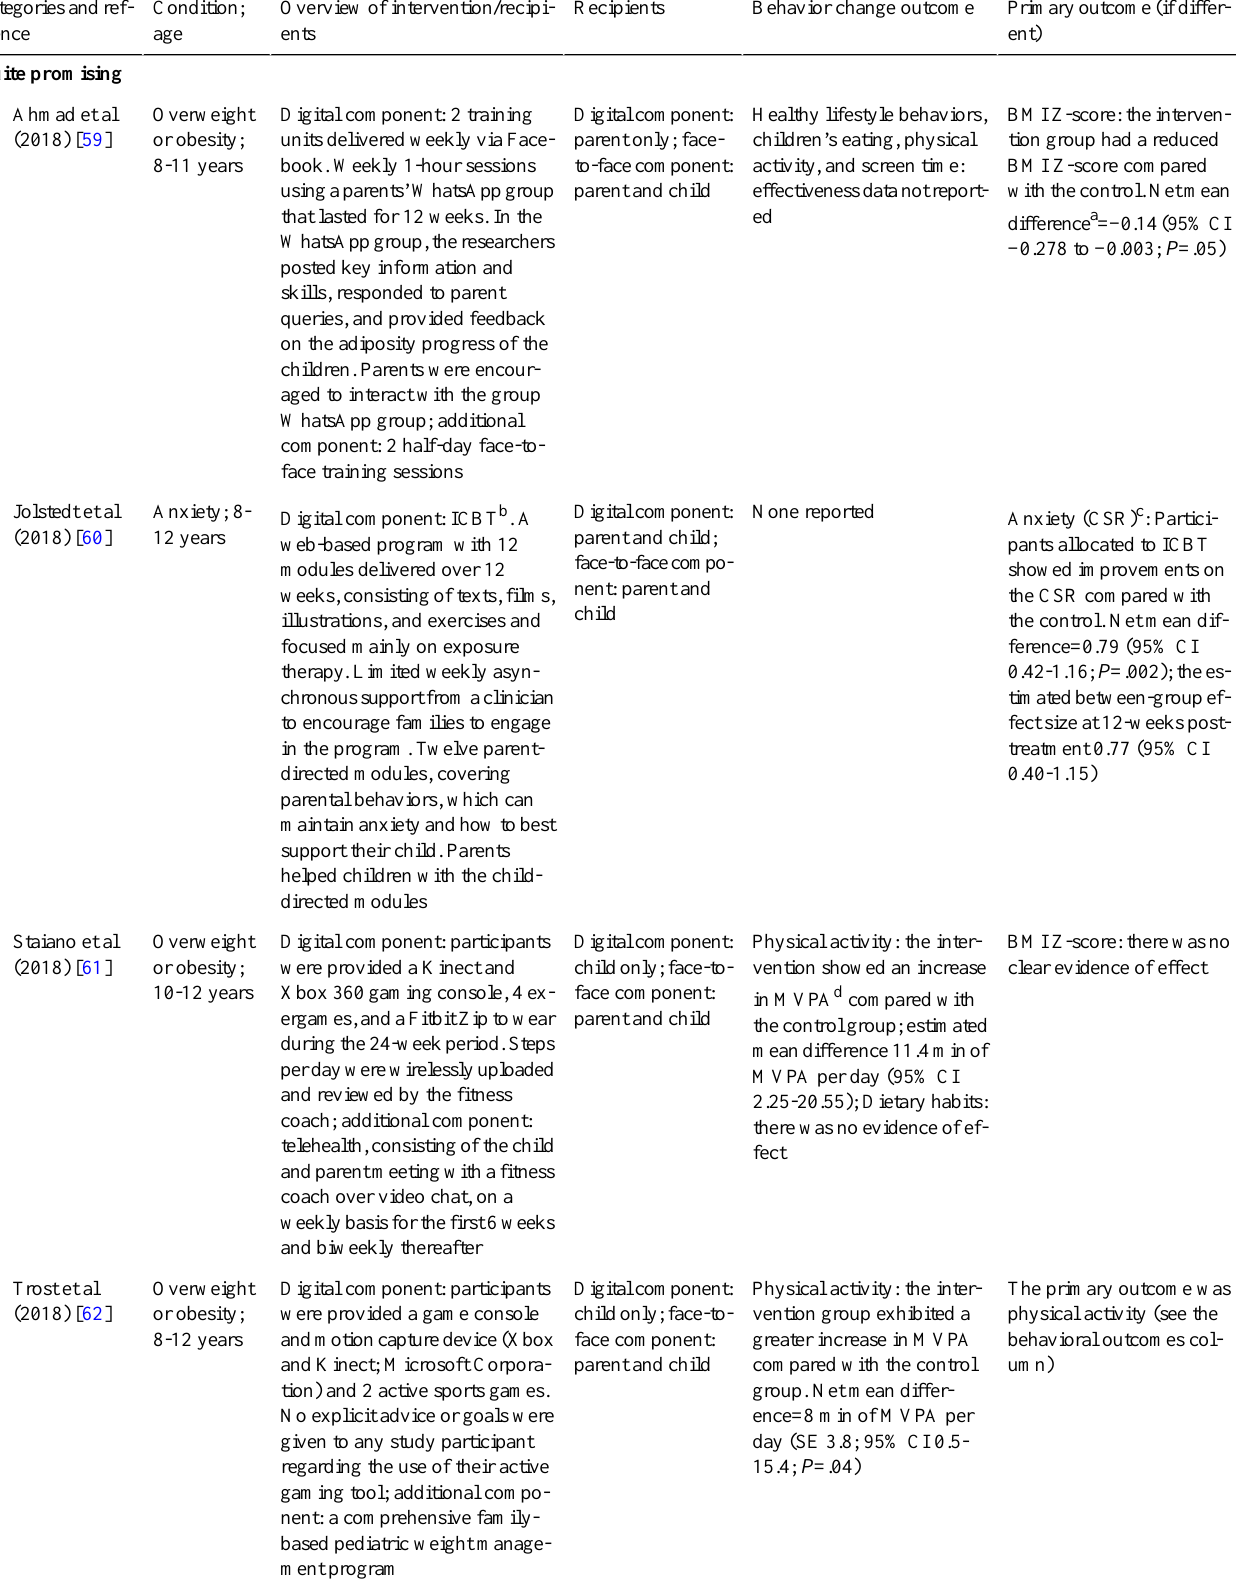
Table 2. Data on population, interventions, and effectiveness of behavior change outcomes and primary outcomes, grouped by intervention